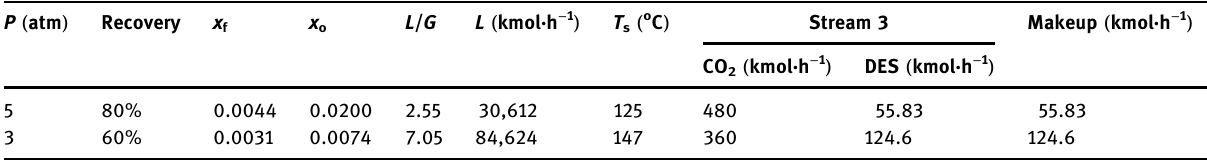
Table 3: The performance of CO 2 capture process at low recovery rate P ( atm )